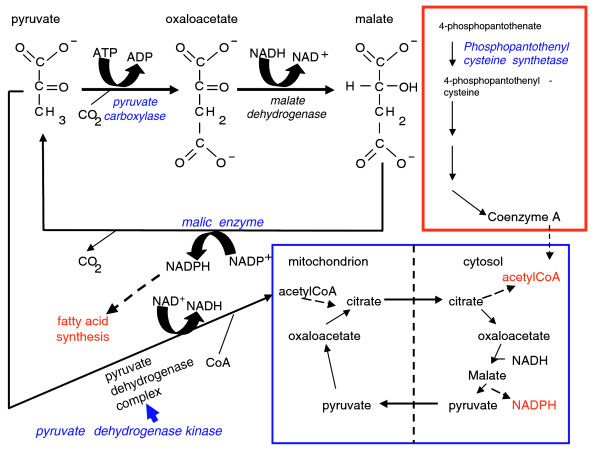
Identification of a conserved metabolic network likely to be associated with alcohol sensitivity in flies and humans. Ethanol is converted via the alcohol dehydrogenase and aldehyde dehydrogenase reactions into acetate, which is subsequently conjugated to co-enzyme A (CoA; not shown). The biosynthetic pathway of co-enzyme A is schematically depicted in the red box. Acetyl-CoA produced in excess can be converted into fatty acids. The diagram highlights auxiliary pathways for the biosynthesis of fatty acids. The blue box illustrates how pyruvate carboxylase and malic enzyme mediate a cyclic metabolic pathway, which via the mitochondrial citrate and pyruvate transporters results in the net transport of acetyl-CoA across the mitochondrial membrane and generation of cytosolic NADPH, both critical substrates for fatty acid metabolism. An alternative metabolic pathway is the direct conversion of pyruvate into acetyl-CoA via the pyruvate dehydrogenase complex. This complex is inhibited through phosphorylation by pyruvate dehydrogenase kinase.